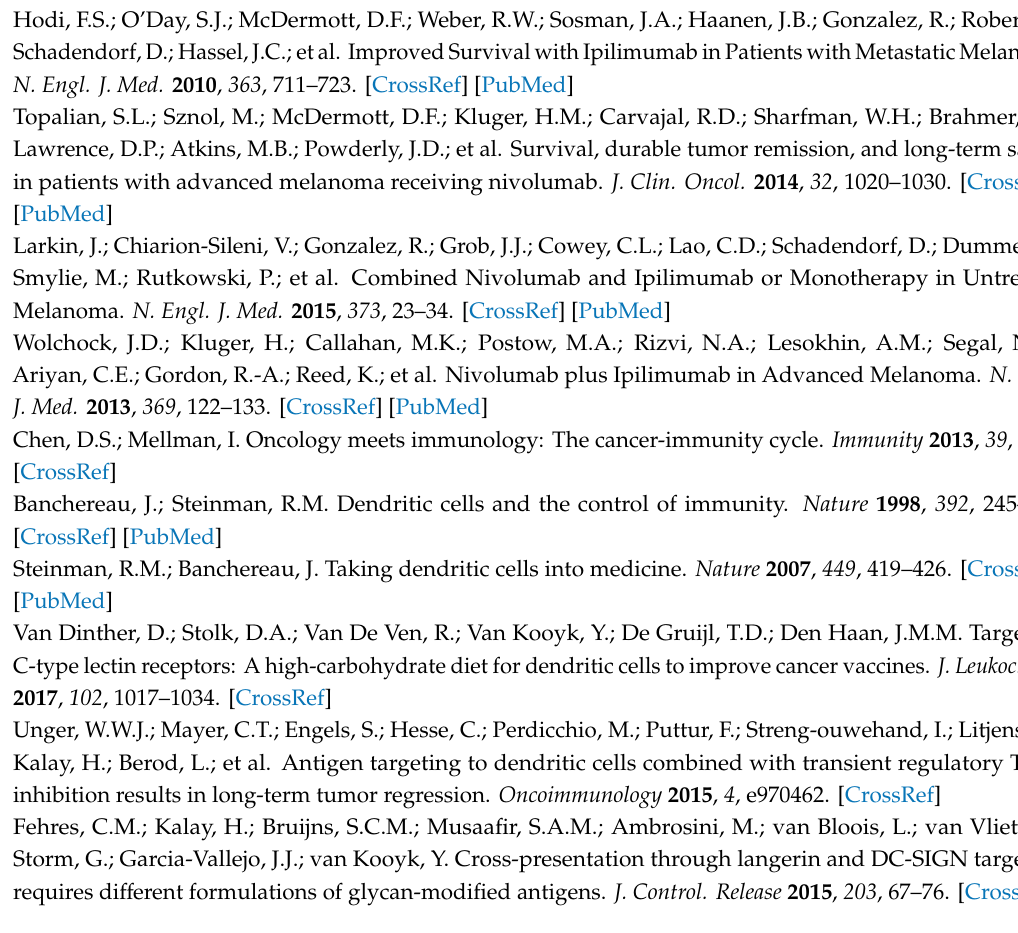
Figure S1: MoDCs favor ApoEVs–HM isolated at 10,000 × g . MoDCs were incubated with DiD-labeled ApoEVs or ApoEVs-HM (50 µ g / mL) isolated at 1200 × g and 10,000 × g for 45 min at 4 ◦ C, before cells were transferred to 37 ◦ C for 60 min. Uptake was measured by flow cytometry. Data shown as mean ± SD of n = 4. Data analyzed with one-way repeated measures ANOVA with Tukey post-hoc test, * p < 0.05. Figure S2: Profile of size distribution of ApoEVs and ApoEVs-HM, measured by nanoparticle tracking analysis (NTA). Figure S3: SK-Mel28-derived ApoEVs-HM express DC-SIGN binding ligands. Di ff erent concentrations of SK-Mel28-derived ApoEVs were coated on an ELISA plate and DC-SIGN binding was detected by DC-SIGN-Fc staining. Figure S4: Simultaneous administration of a TLR4-stimulus did not a ff ect ApoEV-HM uptake. Internalization of ApoEVs-HM after 0, 30, and 60 min by TLR4-stimulated moDCs (10 µ g / mL MPLA). Data of n = 2. Figure S5: Allogeneic mixed leukocyte reaction (MLR), ApoEV- and ApoEV-HM-loaded (200 µ g / mL) and LPS-stimulated moDCs and violet tracer stained peripheral blood lymphocytes (PBLs) were co-cultured for 7 days. T cell proliferation was analyzed by flow cytometry using the violet tracer dilution as a read-out. Data represents the mean + SD and are representative graphs of n = 2. Figure S6: Western blot for the detection of MART-1 protein (18 kDa) in the ApoEVs and ApoEVs-HM. Equal amounts of protein were loaded of lysed ApoEVs and